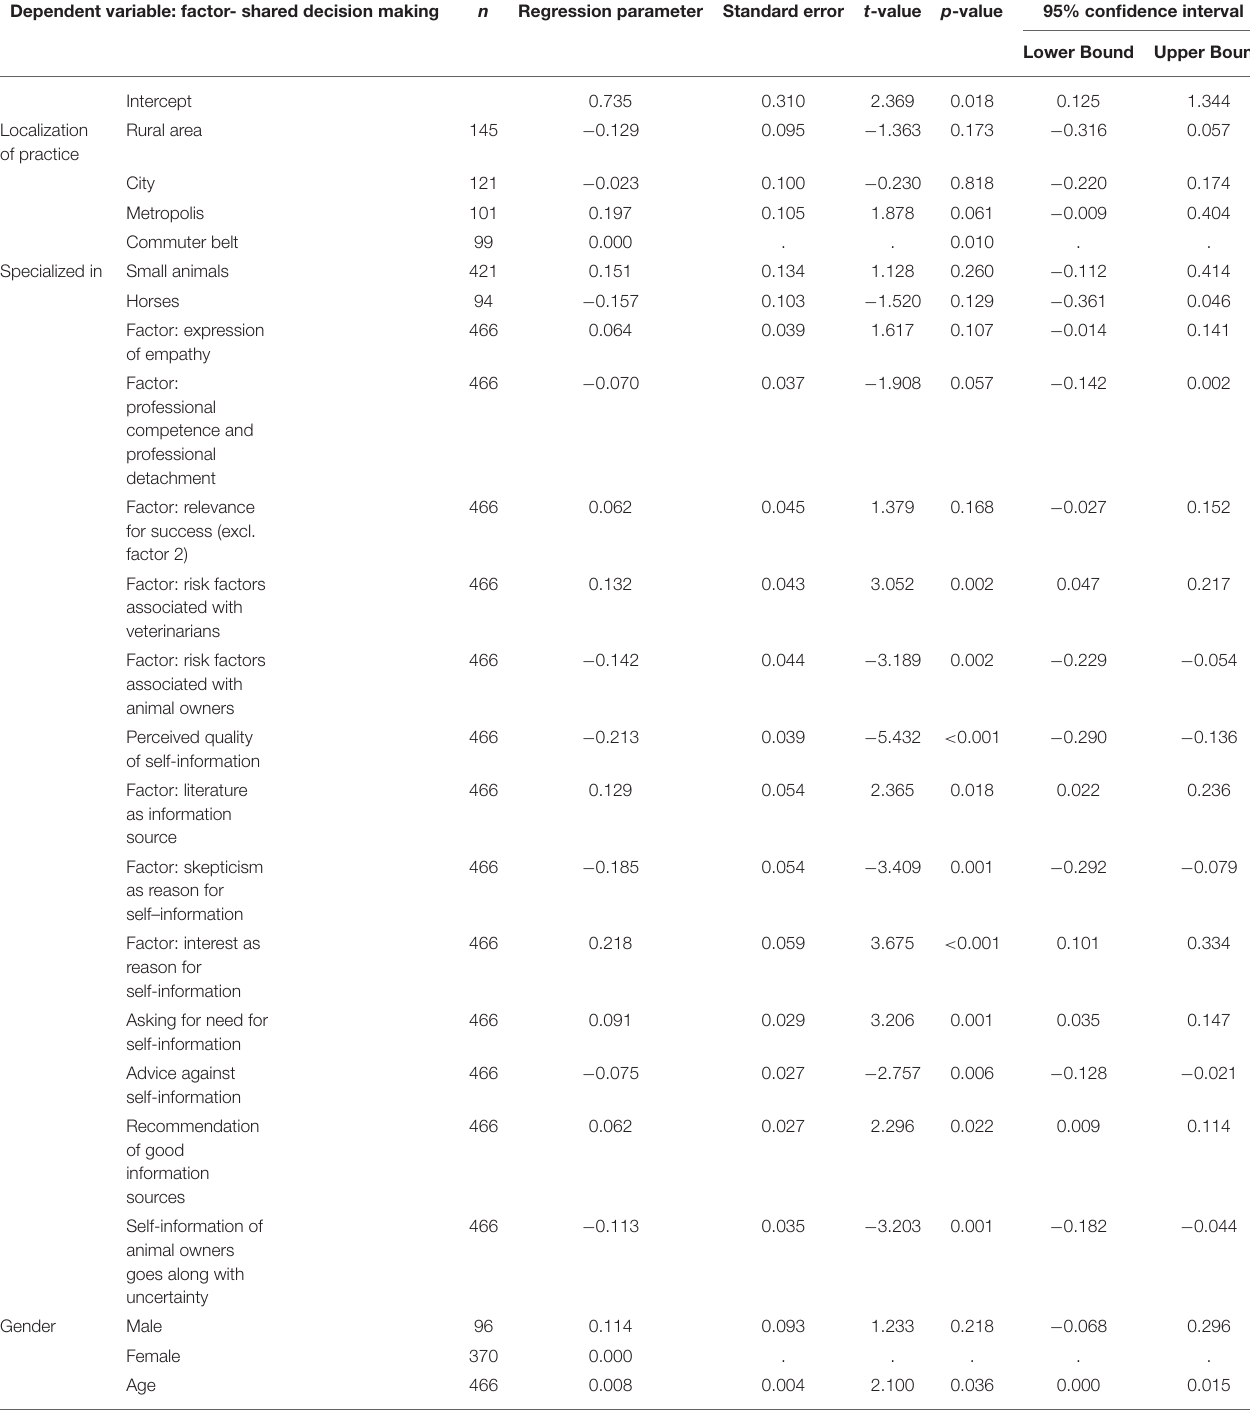
TABLE 5 | Results of the final multivariable linear regression model with SDM as a dependent factor after backward selection. Dependent variable: factor- shared decision